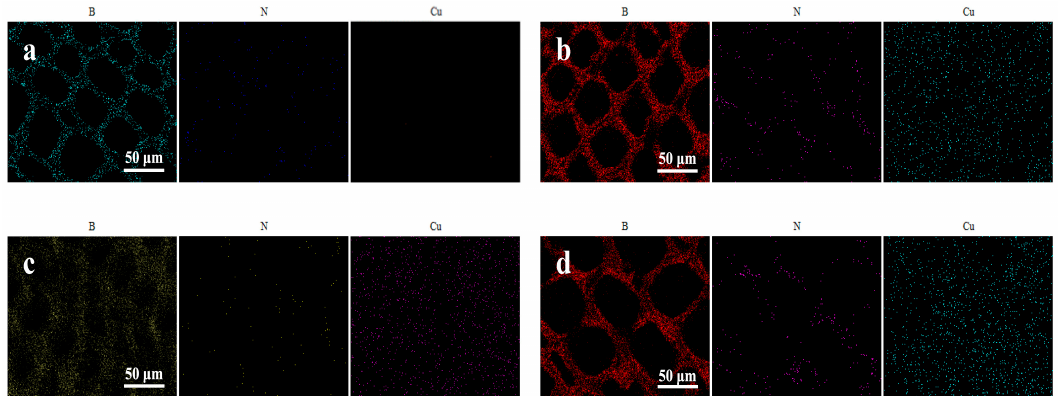
Figure 2. SEM images showing the distribution of B, N and Cu within the wood cell wall. ( a ), control sample, ( b ), sample treated with P 1 , ( c ), sample treated with P 2 , ( d ), sample treated with P 3.